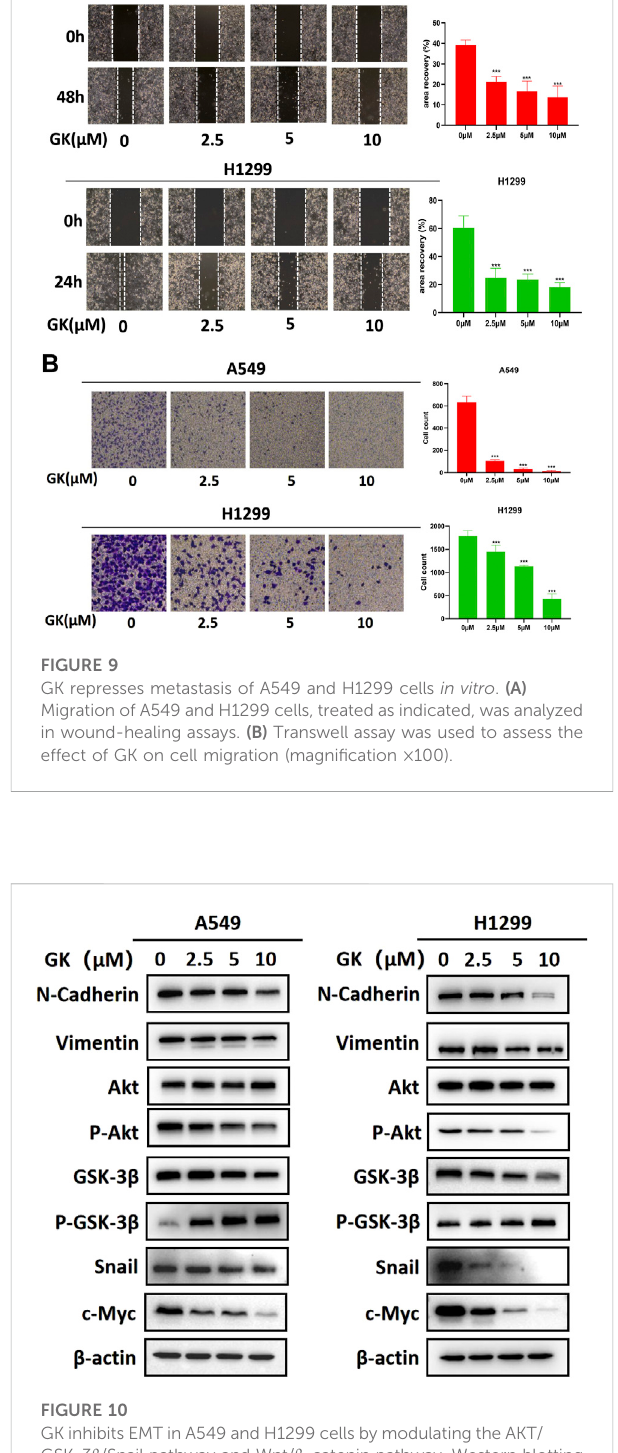
signi fi cantly decreased ( p < 0.05; Western blotting). These results indicate that GK can block Wnt/ β -catenin activation in A549 and H1299 cells (Figure 10).